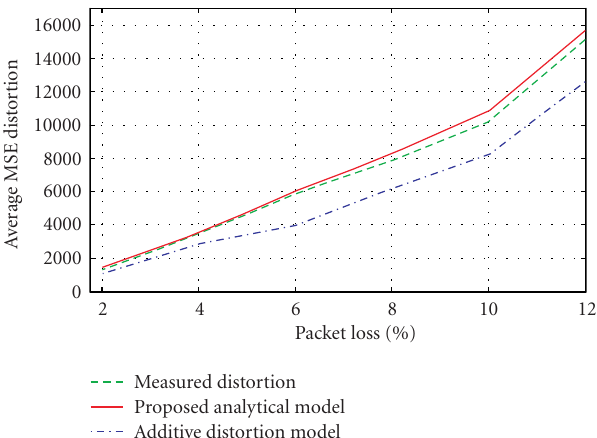
Figure 11: Average total distortion versus packet